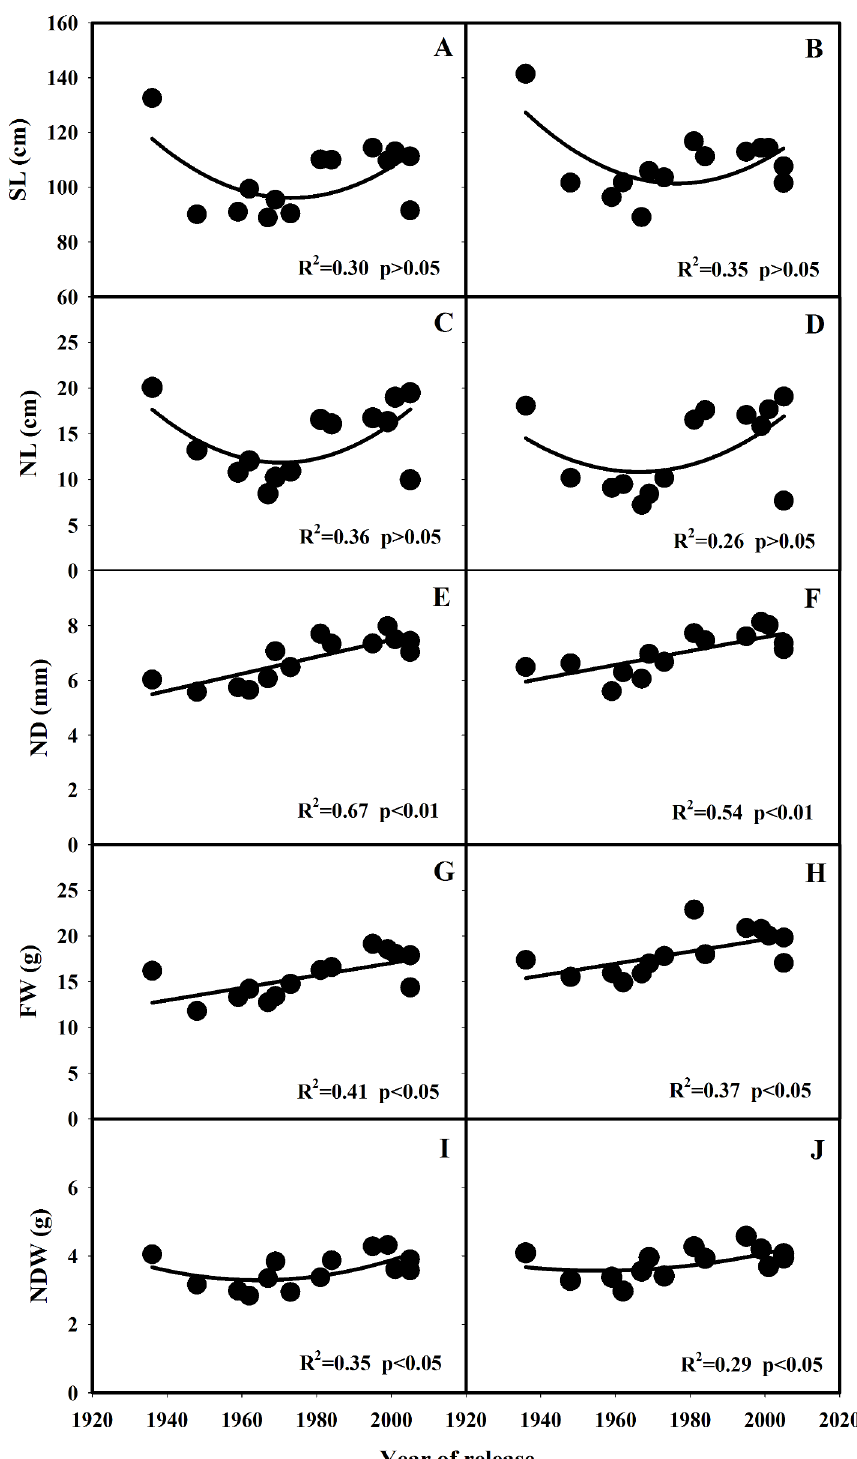
Fig 2. Changes in SL (A, B), NL (C, D), ND (EF, f), FW (G, H) and NDW (I, J) with the year of release of the varieties grown in 2013 and 2014. SL: stem length from the base of N 3 internode to the tip of the panicle, NL: N 3 internode length, ND: N 3 internode diameter, FW: stem fresh weight, NDW: N 3 internode dry weight.